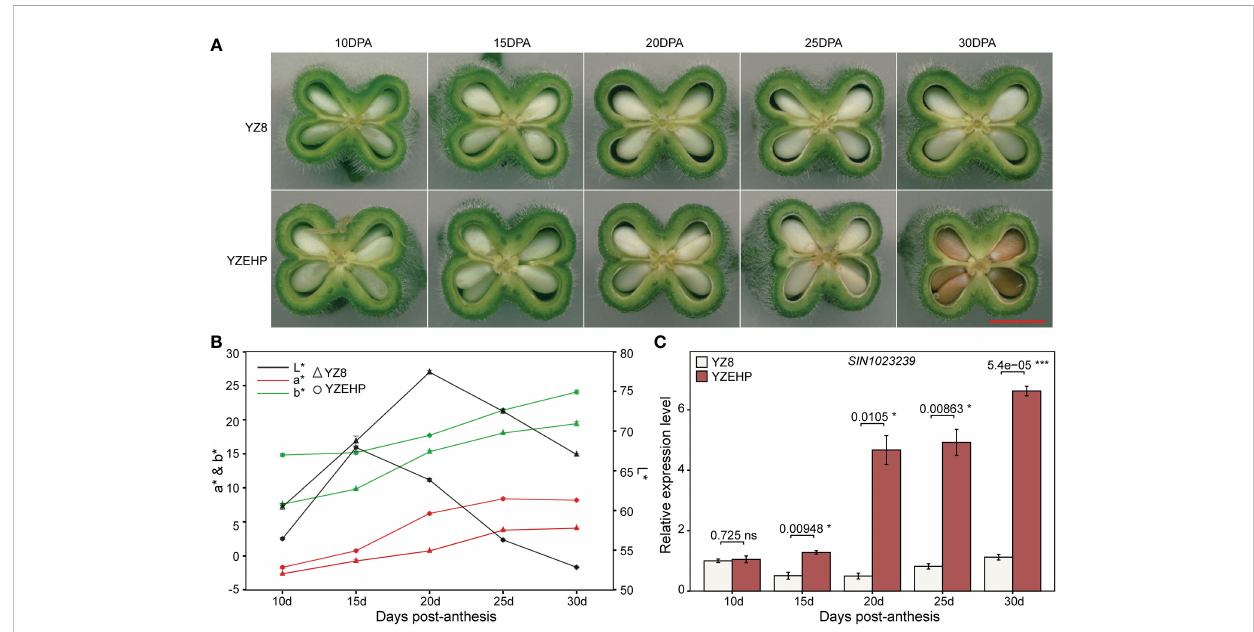
FIGURE 4 Phenotype and gene expression of parental seed coat at different developmental stages. (A) Longitudinal sections of capsules, red line segments indicate 0.5 mm. (B) Values of L*, a*, and b* for different developmental stages of the parental seed coat. (C) Relative expression of SIN_1023239 gene in the two parents. Signi fi cant levels of relative gene expression were determined by T-test, with ns, *, and *** representing nonsigni fi cant, and signi fi cant at p <0.05 and p <0.001 levels,